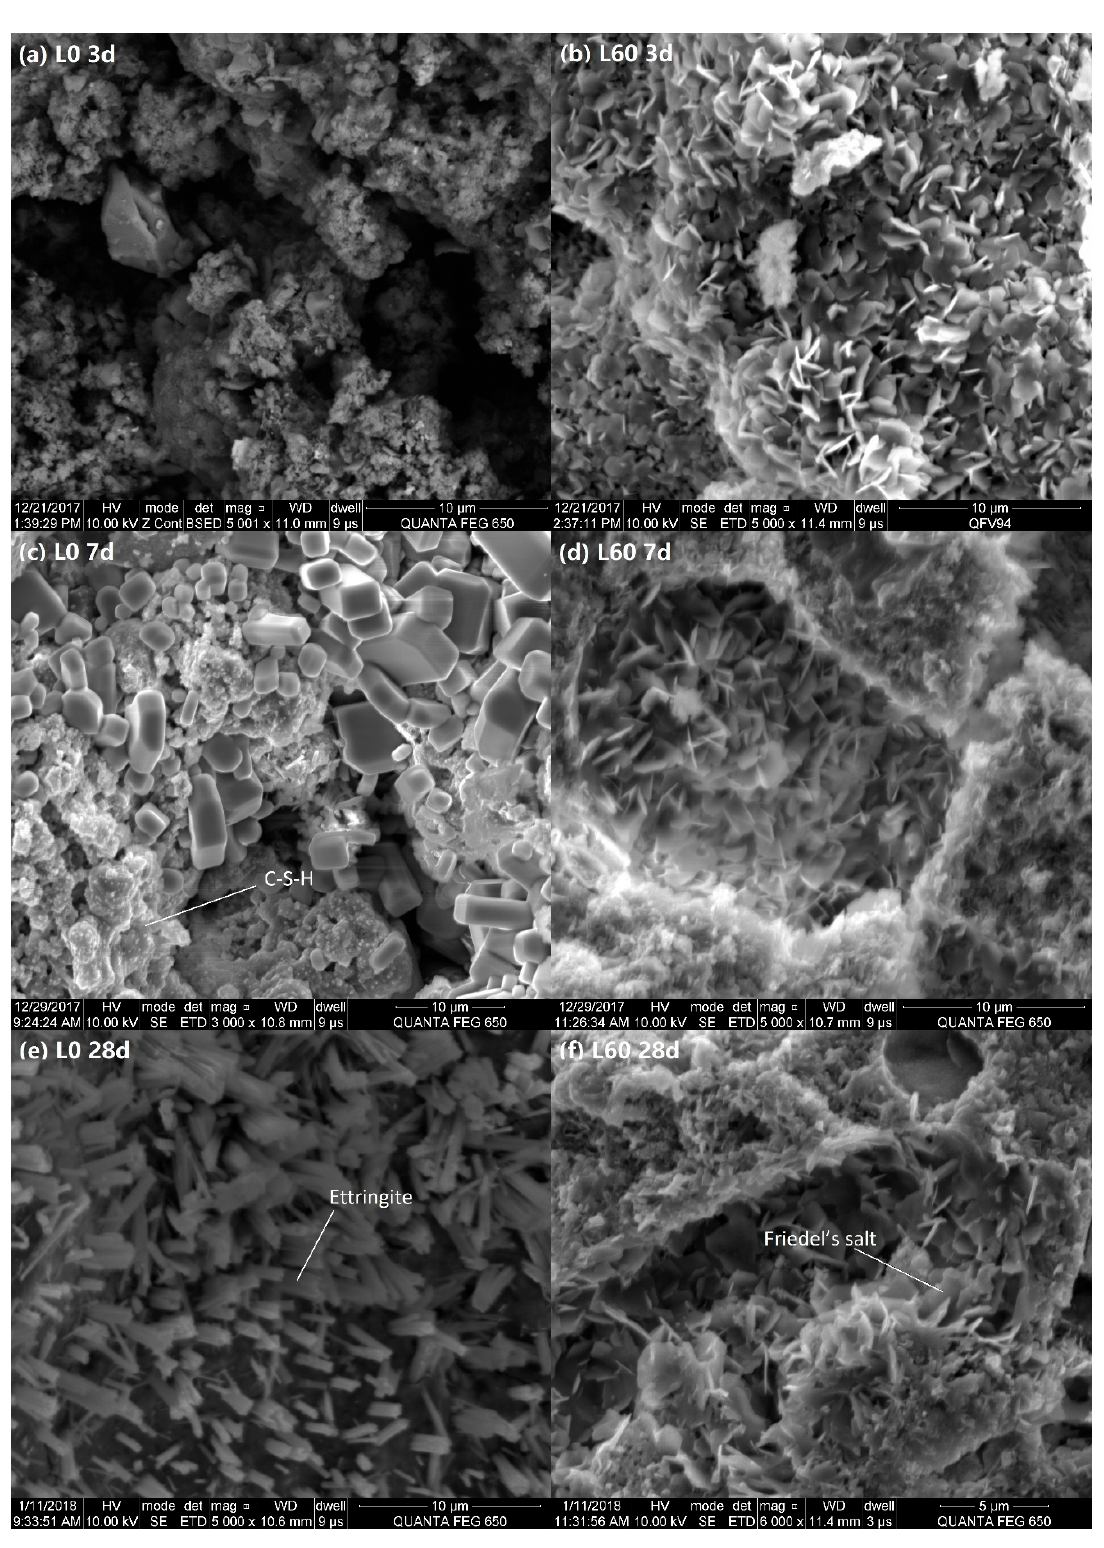
Figure 8. SEM images of L0 and L60 pastes at 3, 7, and 28 days. ( a ) L0 3 days; ( b ) L60 3 days; ( c ) L0 7 days; ( d ) L60 7 days; ( e ) L0 28 days; ( f ) L60 28 days.